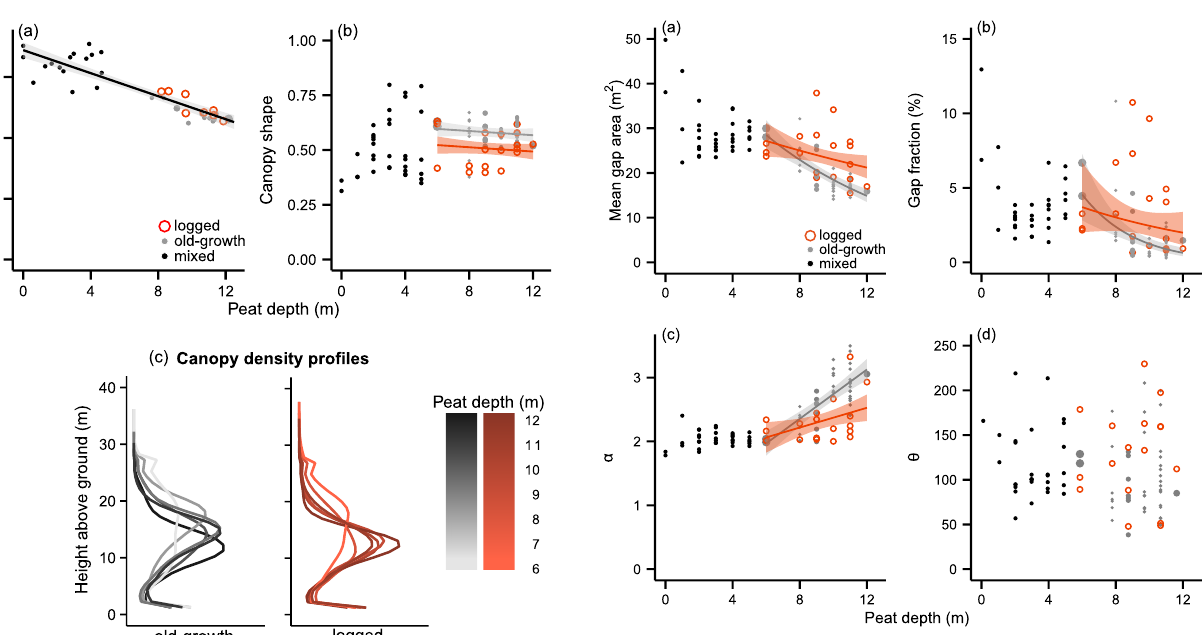
Figure 3. Changes in (a) canopy top height and (b) canopy shape with peat depth in old-growth, logged and mixed peat swamp for- est plots (top panels) and (c) canopy density profiles derived from ALS for old-growth and logged plots on different peat depths (bot- tom panels; the area below each curve is 1). For canopy top height only plots with direct peat measurements are shown and a single regression line is fitted as logging does not affect this metric in an independent data set (Sect. 2.3.1, Supplement). Logged forest dom- inated the first half of the peat depth gradient (0 to 5m peat depth) preventing any comparison between old-growth and logged plots on the shallower peats. Fitted regression lines are plotted with 95% confidence intervals.